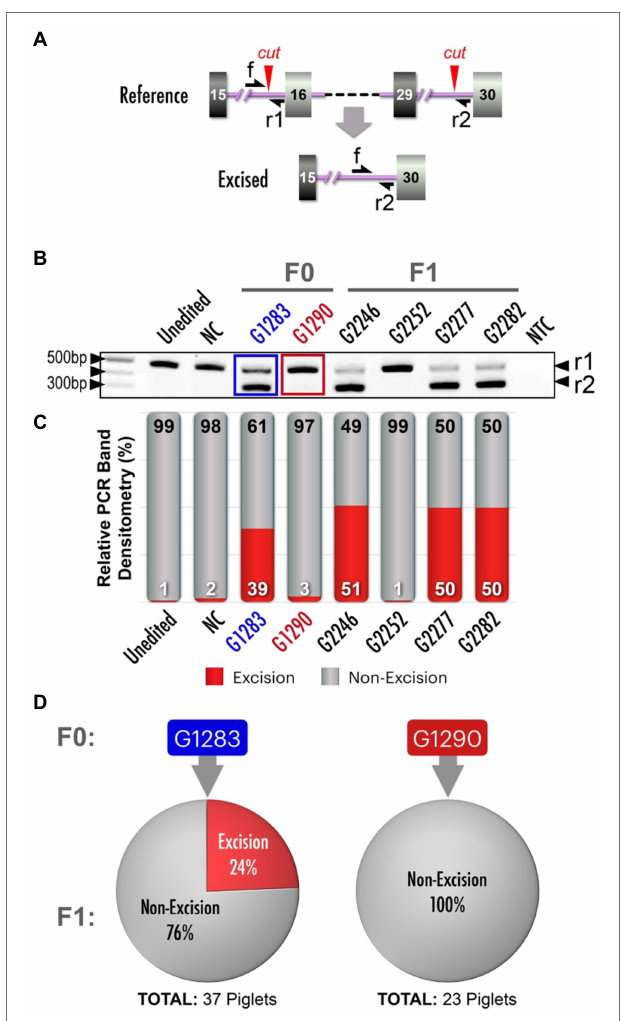
FIGURE 4 | NF1 23 kb excision and analysis of mosaicism. (A) Schematic depicts alterations between NF1 exons 15/16 and 29/30, resulting in a 23 kb excision. Red arrowheads: Cas9 cut sites, single-headed black arrows (f, r1, r2): primer annealing sites. (B) Competitive PCR for excision and non-excision alleles yields amplicon products of two different sizes, indicated by black arrowheads on right (r1 and r2). Included are an unedited control, a negative control (NC; a founder (G401) from another unrelated NF1 model, two 23 kb excision founders (F0; blue and red labels), F1 offsprings (non-mosaic controls) and no template control (NTC). Black arrowhead (on left): 500 bp, 400 bp and 100 bp markers on DNA ladder (NEB, N0551S). (C) Quantification of the pixel density of PCR products in (B) and additional bands not depicted in panel B (see Supplementary Figure 1 for complete gel electrophoresis image), with bars aligned with corresponding PCR gel wells to identify the most effective breeders carrying the 23 kb excision. (D) Proportionality of F1 pigs from two specific founders in (B) and (C) carrying the excision allele compared to those not carrying the excision allele. Thirty-nine percent of F1 pigs produced by founder pig G1283 carried an excision allele, while none of the F1 pigs produced by founder pig G1290 did so. There was a significant association between excision allele abundance (pixel density) and germline transmission rate (logistic regression, p <